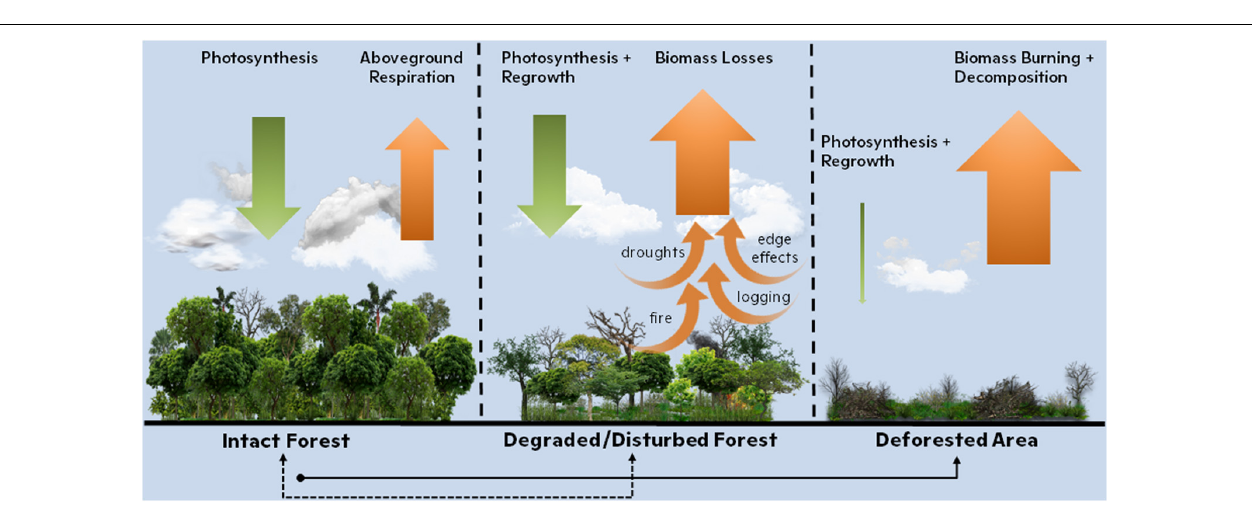
FIGURE 1 | Carbon dynamics in the Brazilian Amazon forest biome. (A) Cumulative aboveground carbon losses (MgC/ha) from 2003 to 2019. (B) Annual carbon dioxide emissions (million metric tons of CO 2 ) from deforestation over the last decade. Deforestation data is from the Brazilian National Space Agency [INPE, 2021] and biomass change data is from Walker et al. (2020). Background image depicts smoke from fires following deforestation near Novo Progress, PA, Brazil (MODIS/Terra images from August 19, 2019; NASA Earth Observatory).